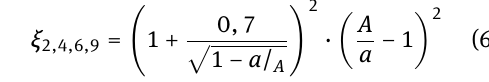
Figure 7: The local aerodynamic drag of the air flow at the outlet part. Upper picture shows conventional rain screen louvers. Lower picture illustrates aerodynamic louvers (a – net opening area for air flow, A – total area of the inlet air, including the louvers).